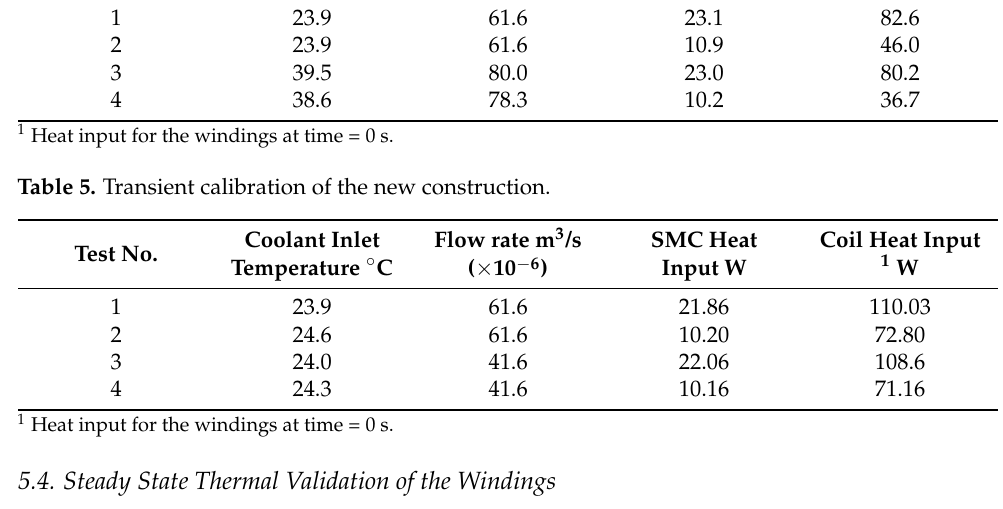
Table 4. Transient calibration of the conventional windings. Test No.